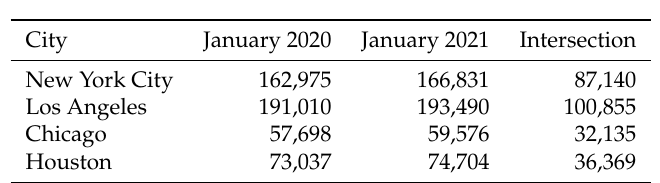
Table 1: Number of places of interest for each city accessed in January 2020 and January 2021. The intersections of the two sets are also